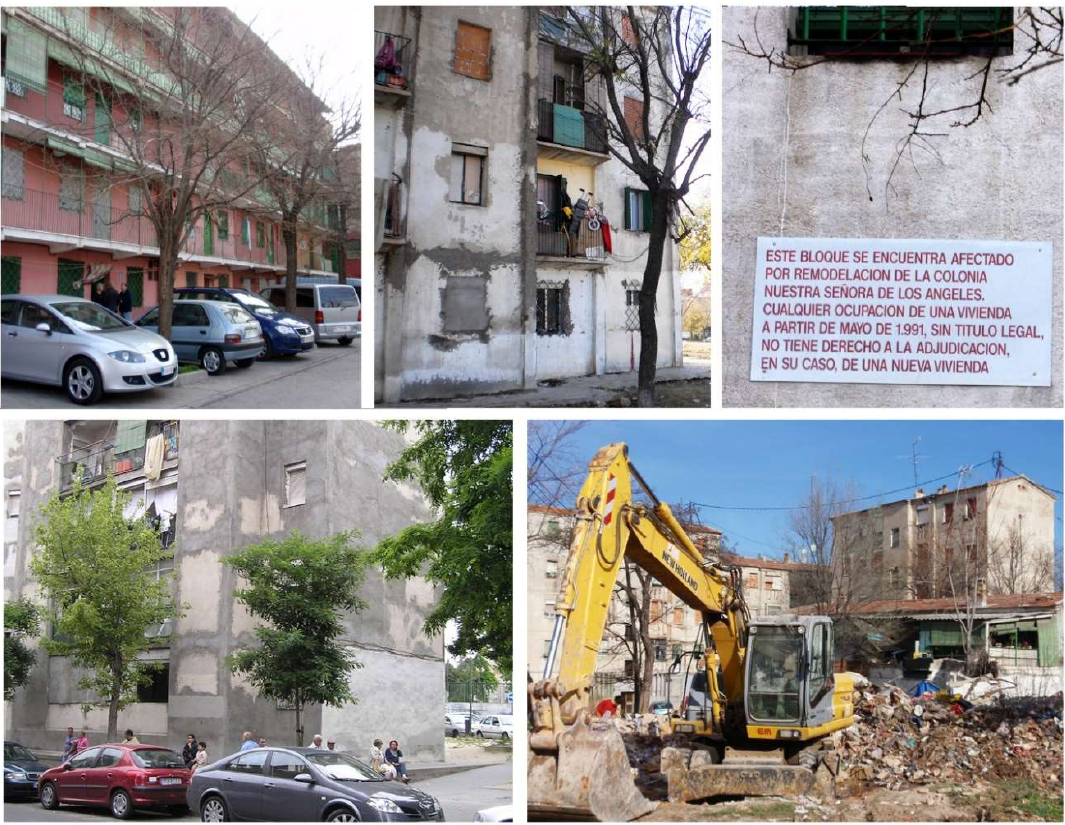
Figure 5. The Nuestra Señora de los Ángeles community in 2008. Some homes are still occupied, while others have been sealed after relocating residents and others have been demolished. (CARTEL: This block is included in the plan to remodel the Nuestra Señora de los Ángeles community. As of May 1991, any occupation of a home without the proper legal title does not imply the right to have a new home adjudicated if applicable). Source: The authors.